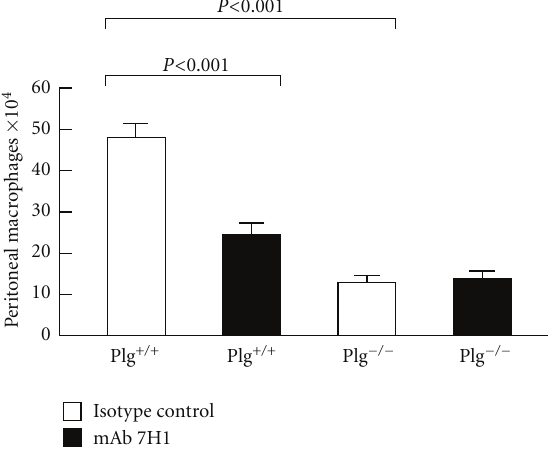
Figure 7: E ff ect of Plg-R KT on thioglycollate-induced monocyte recruitment. Both plasminogen-deficient (Plg − / − ) and wild-type littermates (Plg + / + ) mice were injected intravenously with either mAb7H1 ( (cid:3) ) or isotype control ( (cid:4) ) (500 μ g). After 30 minutes thioglycollate was injected intraperitoneally. A second injection of antibody was given 24 hours later. After 72 hours, thioglycollate-recruited cells were collected by peritoneal lavage and macrophages were purified by adherence. The adherent cells were detached and counted using a hemocytometer. Data represent mean ± S.E.M. n = 5/group). This research was originally published in [20].